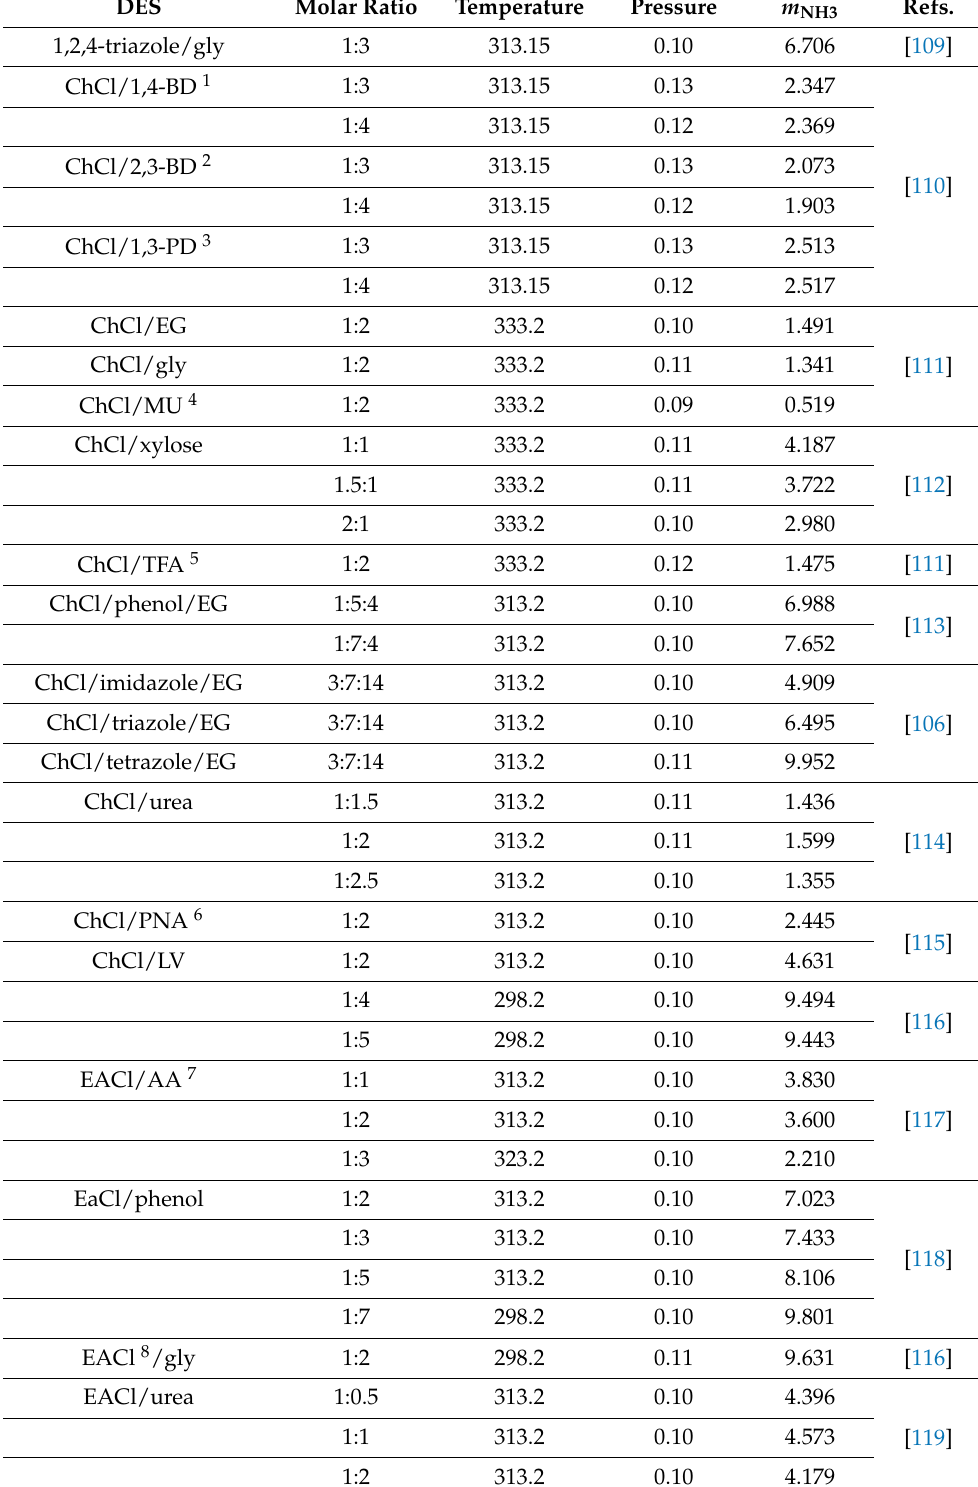
Table 3. The solubility of NH 3 ( m NH3 , mol · kg − 1 ) in DESs at different temperature (K) and pres- sure